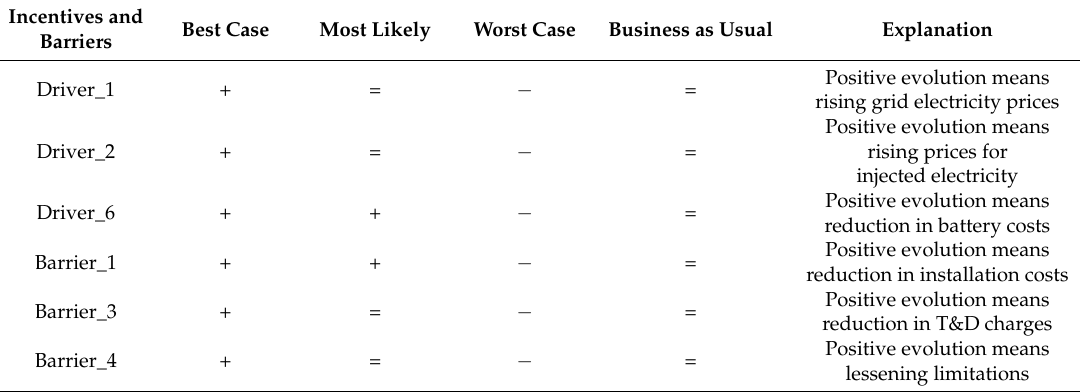
Table 7. Definition of scenarios for self-consumption (own